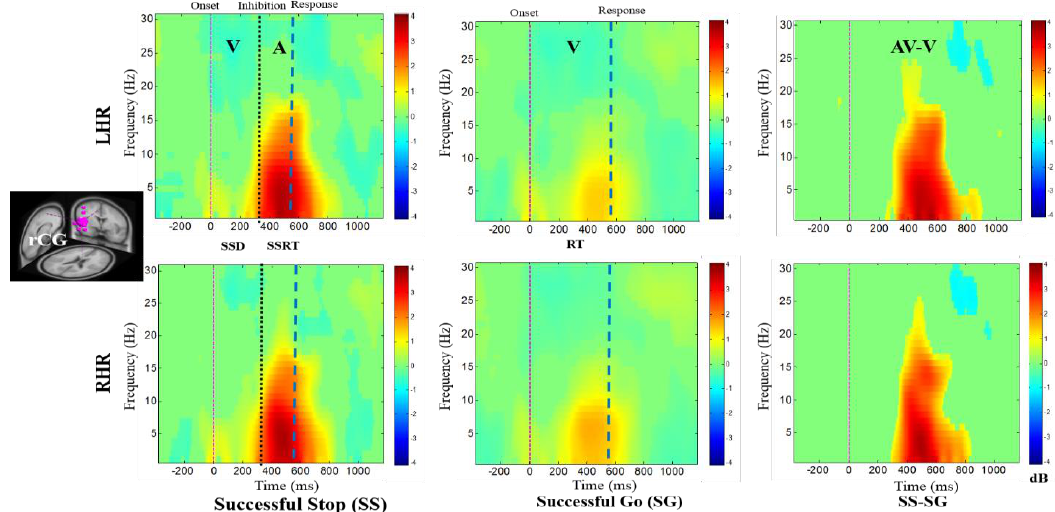
Figure 5. The ERSP plots showing the post-stimuli EEG modulations in the right cingulate gyrus (rCG) of the brain under combined visual (V) stimuli and auditory (A) alarms. The successful go (SG) trial is elicited by only visual stimuli, and the successful stop (SS) trial is elicited by auditory alarms. In (SS-SG) condition, the ERSP plots display the EEG modulation of auditory alarms by comparing the ERSP plots of audio-visual (AV) and visual (V) stimuli; (AV-V). Purple dashed line: Onset of the visual stimuli; black dashed line: Onset of the auditory alarms; blue dashed line: Onset of response. Color bars show the amplitude of the ERSP; statistical threshold at p <